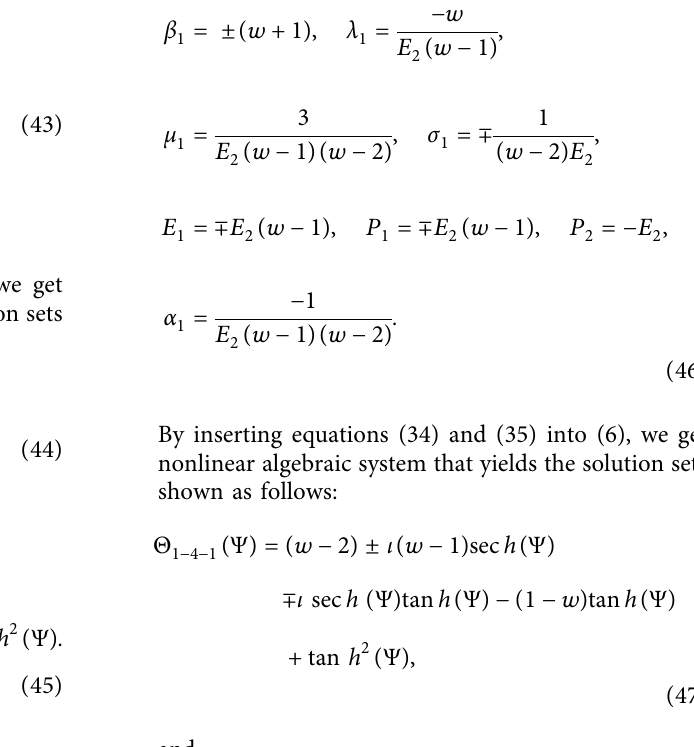
� 0 . 5, and w � 3. (a) Θ 111 , (b) Θ 112 , (c) Θ 111 , Θ 112 1